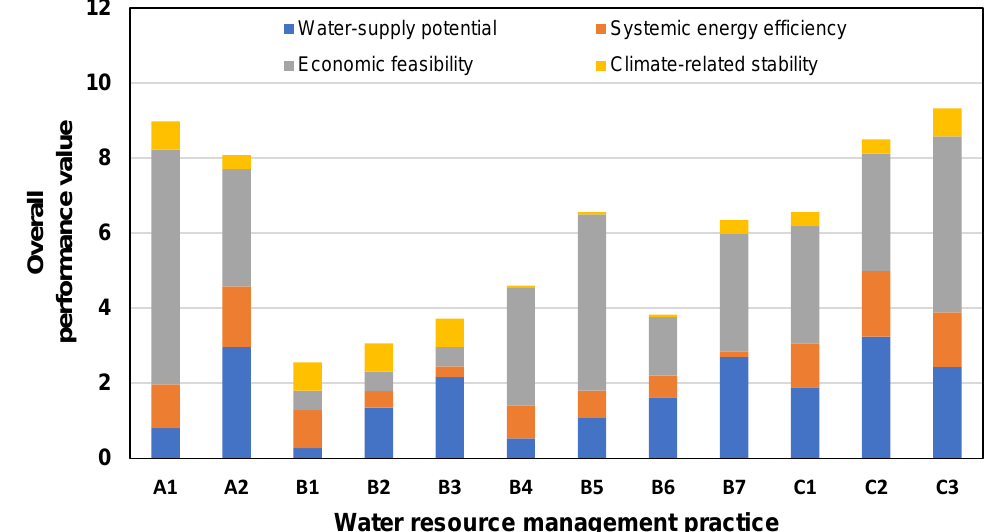
Figure 3. Overall performance value for studied water resource management practices. Ranking of importance: economic feasibility, water-supply potential, systemic energy efficiency, and climate-related stability. Weights of importance for the abovementioned attributes are 0.5208, 0.2708, 0.1458, and 0.0625, respectively, as determined by the SMART technique. Water-supply potential